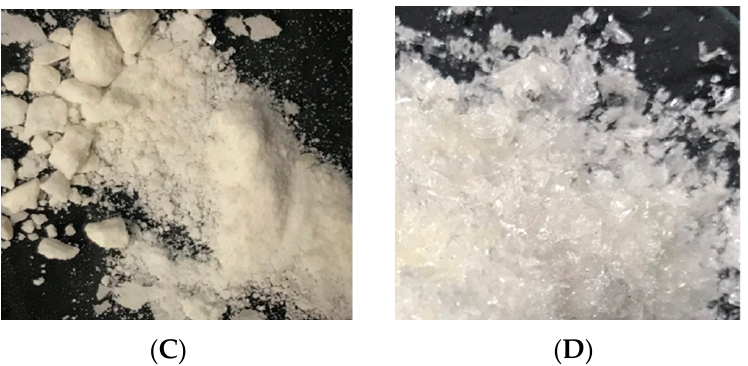
Figure 3. Lactobionic acid product visual assessment immediately after the performance of down- stream approaches. ( A ) Light yellow shades, free-flowing crystalline product; ( B ) Yellow shade syrup (visually reminiscent of honey); ( C ) Light, white colored fluid powder-like product; ( D ) Light, white colored fluid crystalline product.